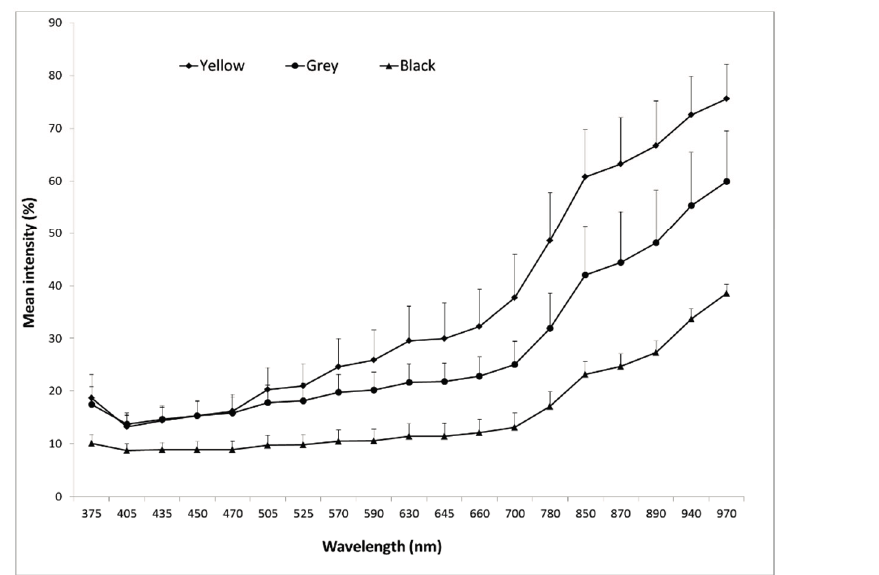
Figure 3. Mean reflectance spectra based on the reflection of the seed coat surface of three seed classes, determined as yellow, grey and black seeds. Vertical bars represent standard deviation (only upper directions bars are shown, to avoid overlapping of bars) from single seed